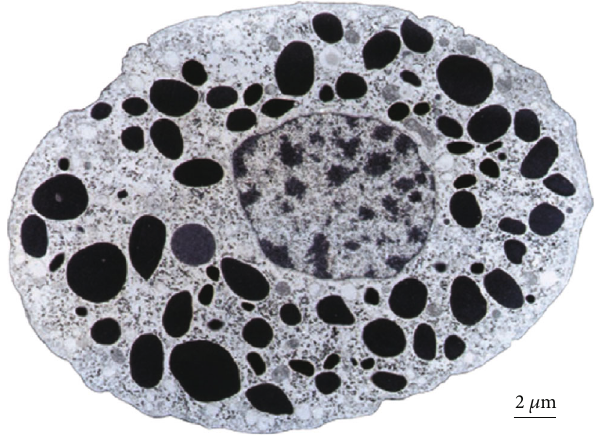
Figure 3: A cross-section of a granular hemocyte under electron microscopy